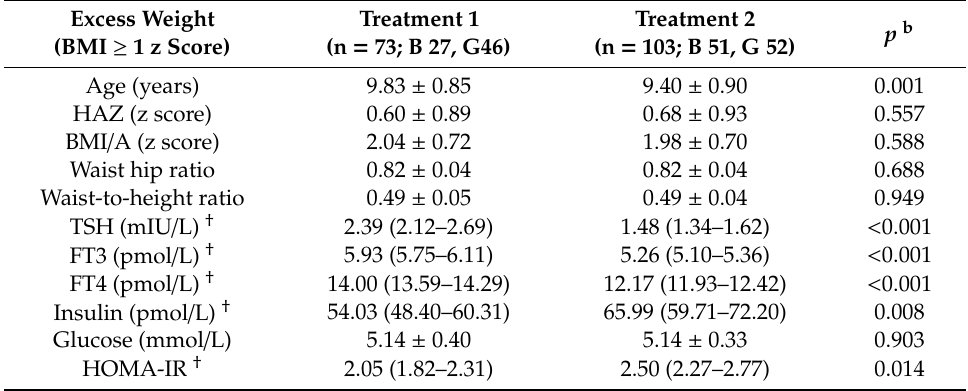
Table 1. Anthropometric and hormonal profile at baseline in both interventions a .